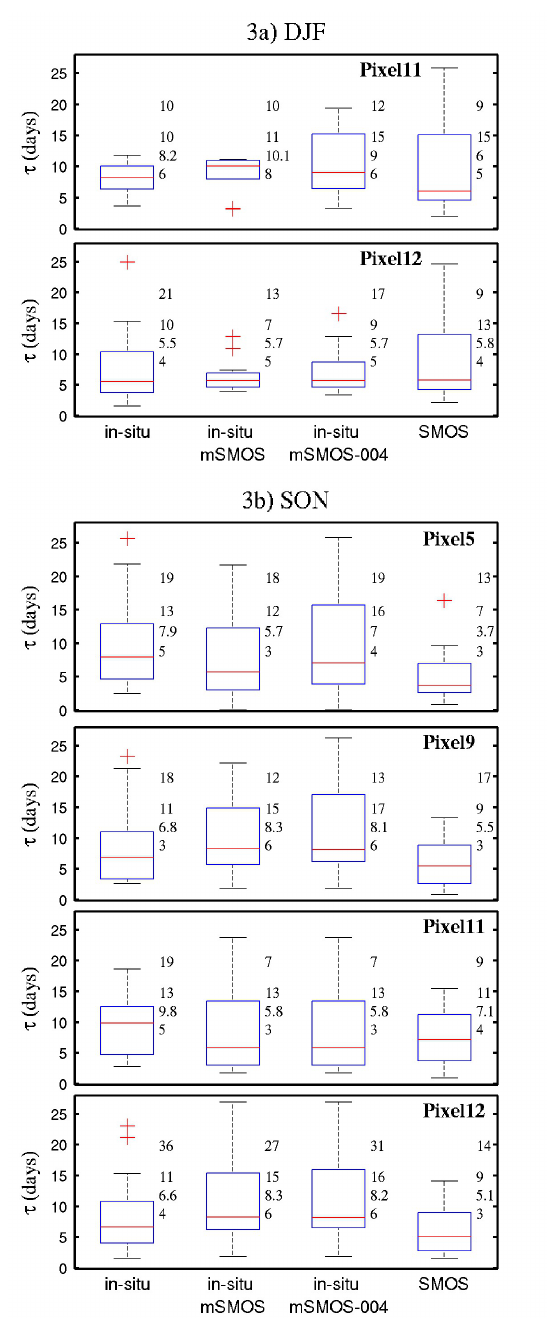
Figure 3. Dry-down time scale ( (cid:2254) ) distributions in Pixel11 and Pixel12 in DJF (Fig.3a) and Pixel5, Pixel9, Pixel11 and Pixel12 in SON (Fig.3b), for In-situ (1st), In-situ_mSMOS (2nd), In- situ_mSMOS_004 (3rd) and SMOS (4th) in 4 selected SMOS pixels. Median and IQR values are represented by the red line and the blue box respectively. Numbers close to each boxplot show (from top to bottom): number of drydown events, percentiles 75, 50 (median) and 25 of each